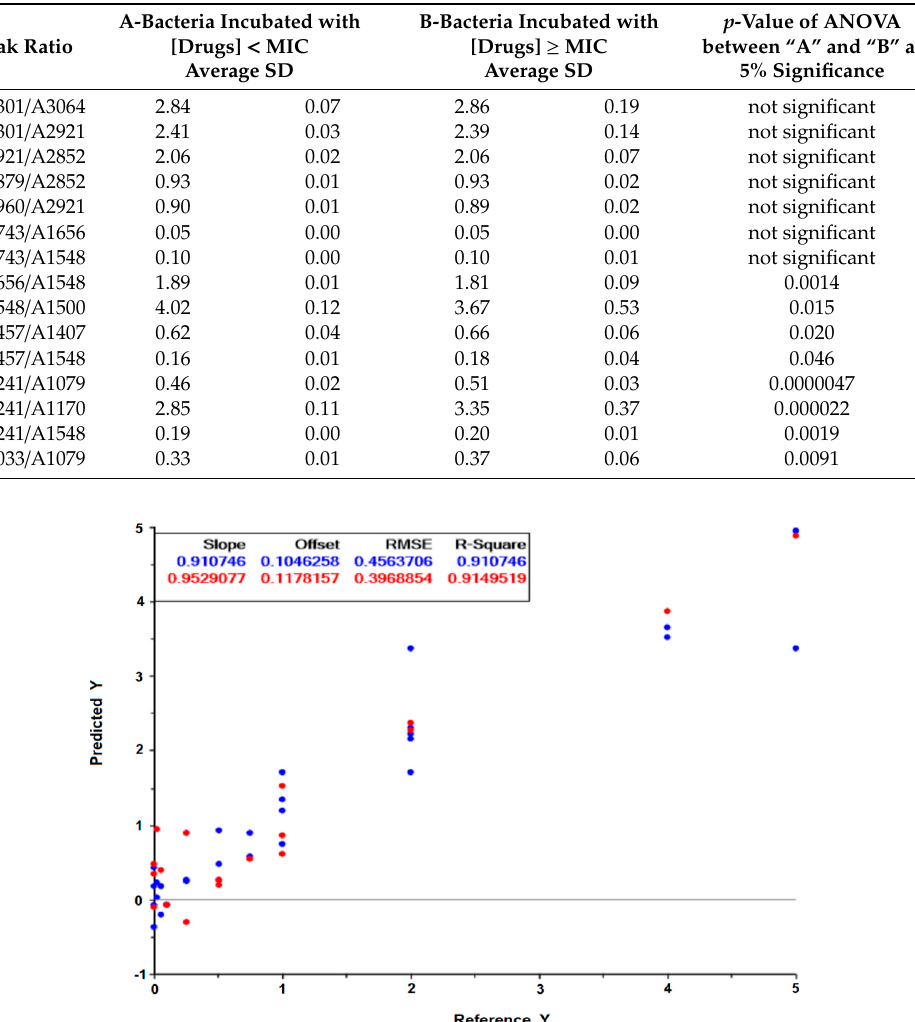
Figure 8. Predicted drug concentration in relation to the experimental drug concentration, obtained from the PLS regression model built on 7 latent variables. The incubation of the reference 26,695 and J99 H. pylori strains with the peptide-based antimicrobial and clarithromycin, respectively, were considered. The graph scales are relative to the MIC of the drug. Blue and red symbols are relative to the calibration and validation model, respectively.